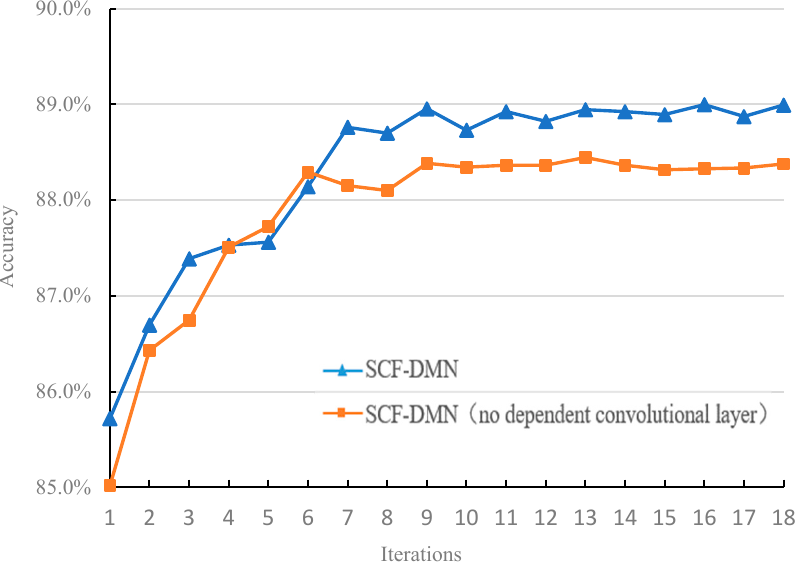
Figure 7. The learning curve on SNLI of SCF-DMN (different fusion layers).